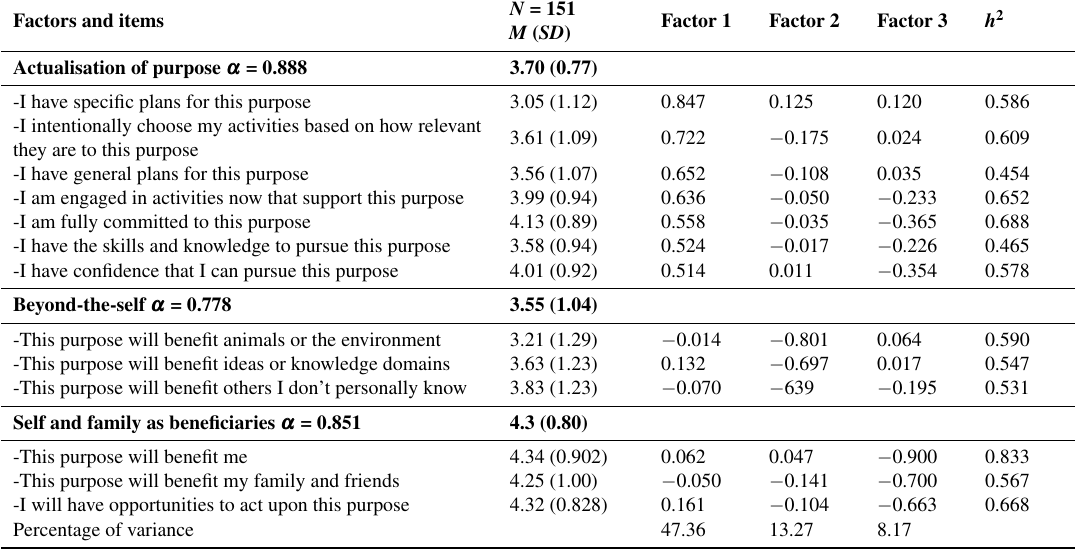
Table 1. Purpose Characteristics Questionnaire: Factor loadings, communalities ( h2 ), and percentages of